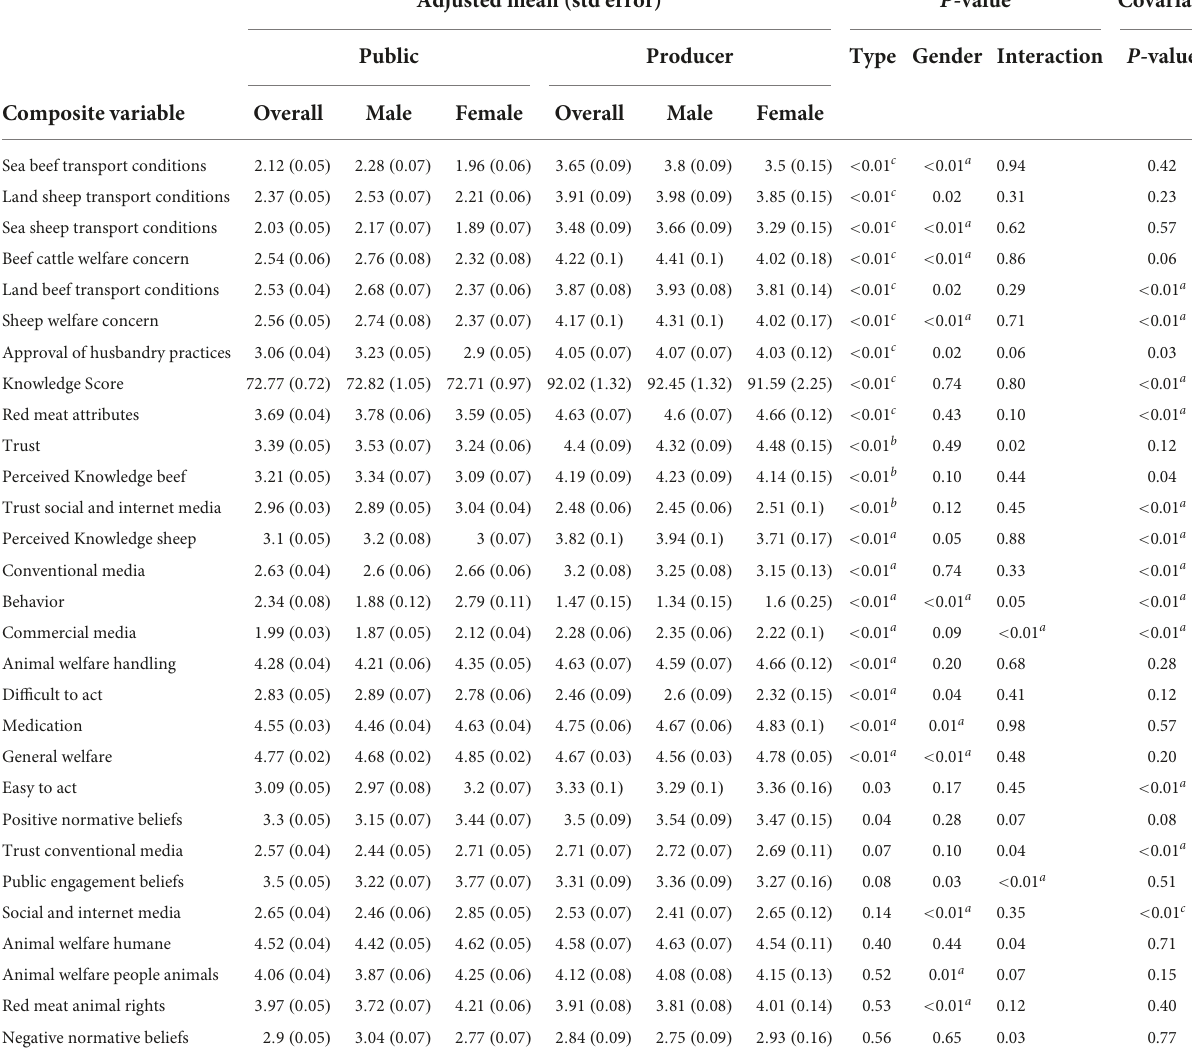
TABLE 4 The effects of type of respondent (public and producer) and gender, with age as a covariate, on the composite